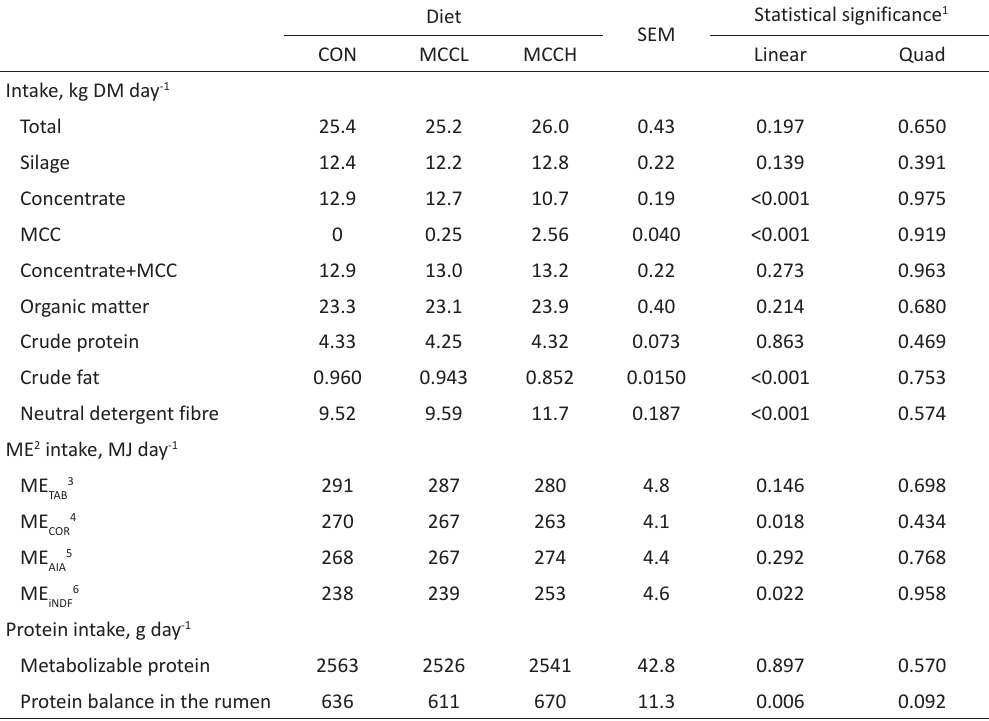
Table 4. Feed and nutrient intake of dairy cows fed microcrystalline cellulose